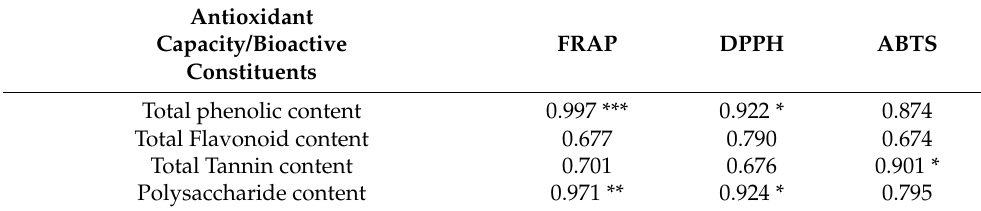
Table 4. Pearson correlation coefficient of the A. hendersonii bioactive constituents and antioxidant capacities.